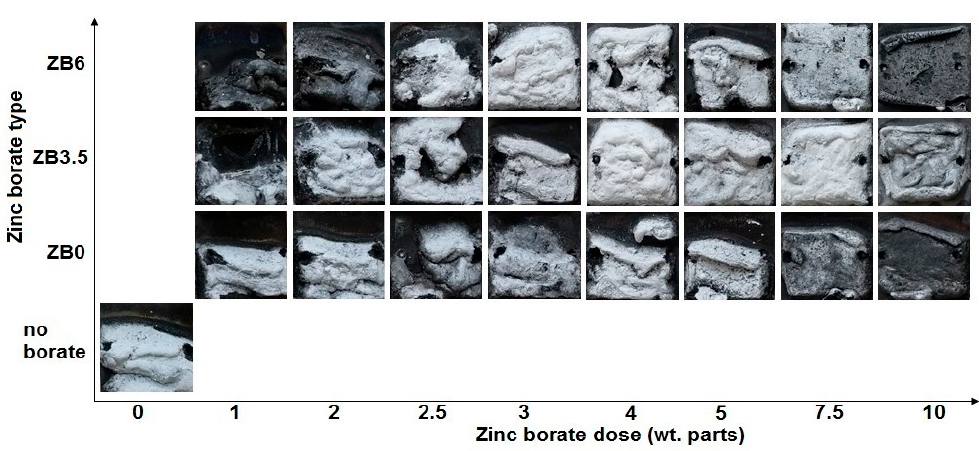
Figure 4. Digital images of the charred intumescent coatings (after the furnace test) with various zinc borates.